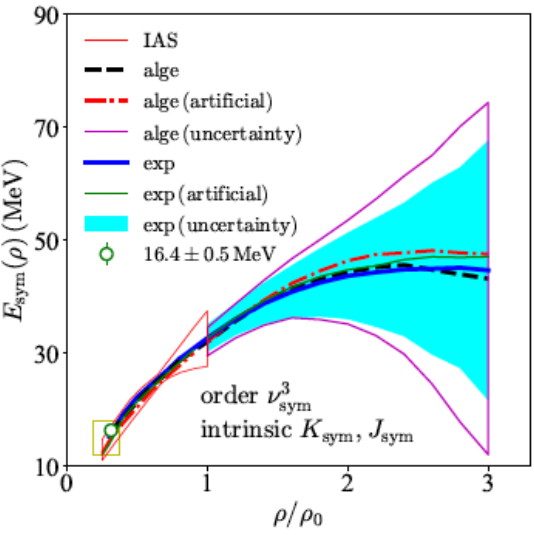
Figure 22. Symmetry energy reconstructed via the auxiliary functions in the exponential and algebraic models with Test Set III (adopting the intrinsic correlation between K sym and J sym imposed by the unbound nature of PNM). Taken from